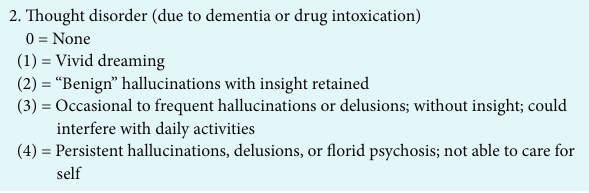
Figure 1: UPDRS Part I questions 1 and 2